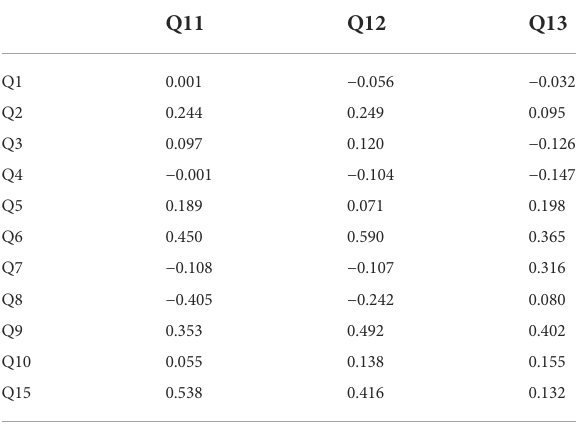
TABLE 1 Pearson ’ s correlation coef fi cients of questionnaire answers among working-age people.